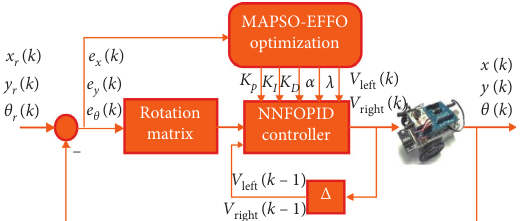
Figure 2: The NNFOPID-based trajectory tracking controller for